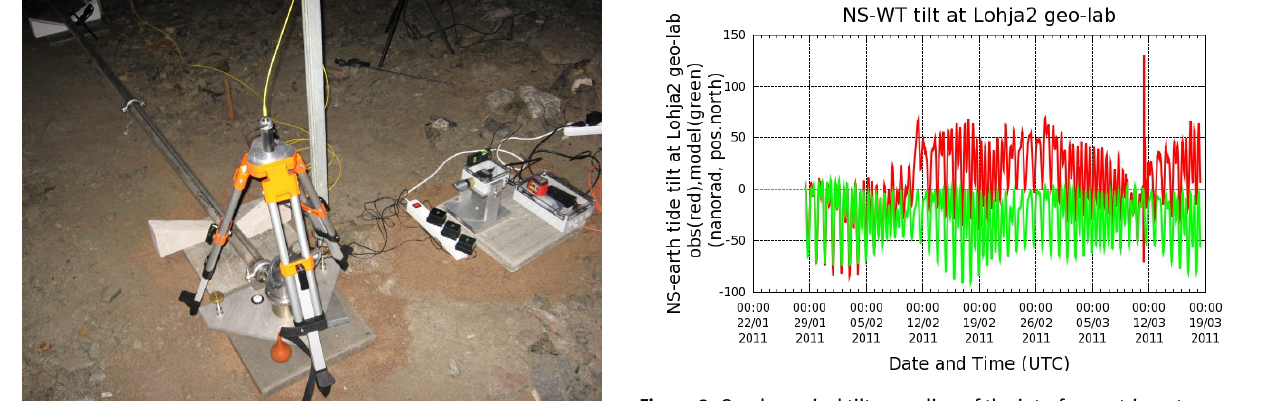
Figure 2: Geodynamical tilt recording of the interferometric water level tilt meter (red) and earth tide model tilt